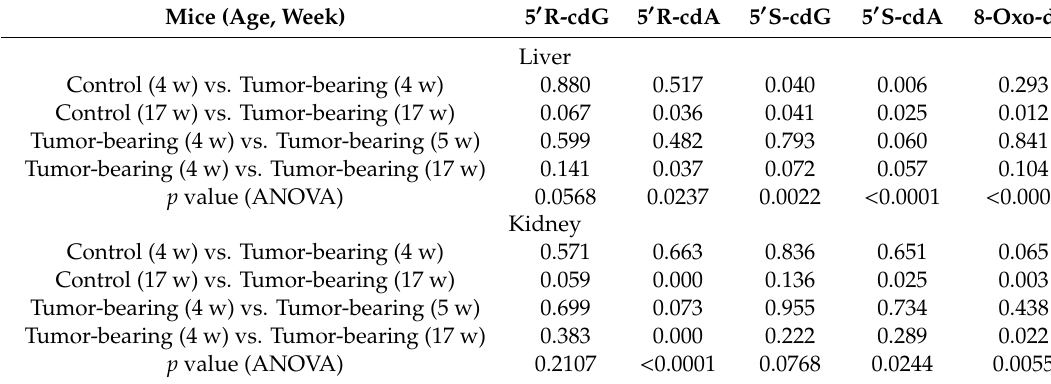
Table 2. Values of t -test (Two-Sample Assuming Unequal Variances) are given by comparing the means of lesions in each specific age point of mice in liver and kidney, respectively. In the same table, p value is included, which represent the comparison among all the groups after conducting one-way ANOVA test in parallel with multiple comparisons of all groups ( n = 3), w: